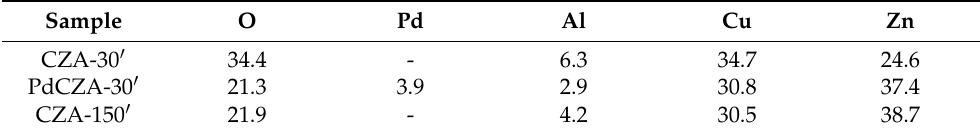
Table 1. EDS analysis results (%